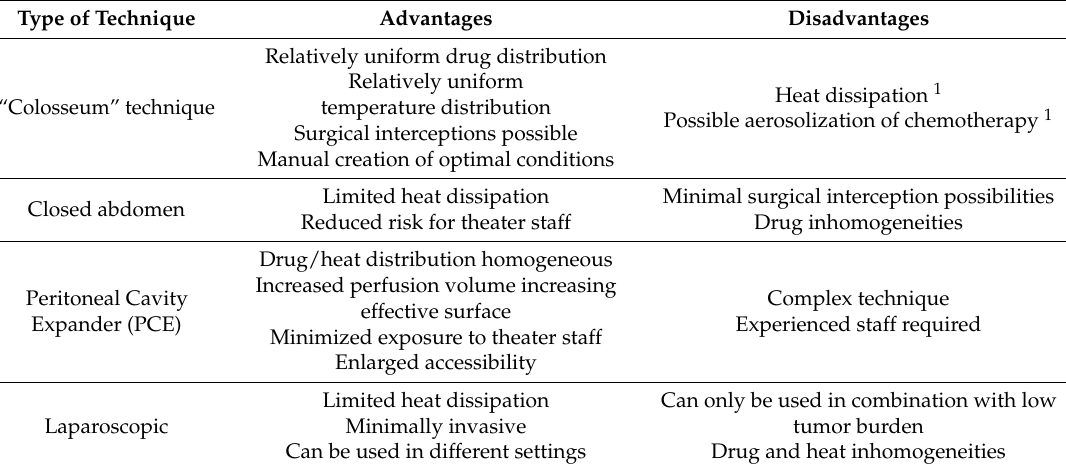
Table 4. Comparison between the four different available